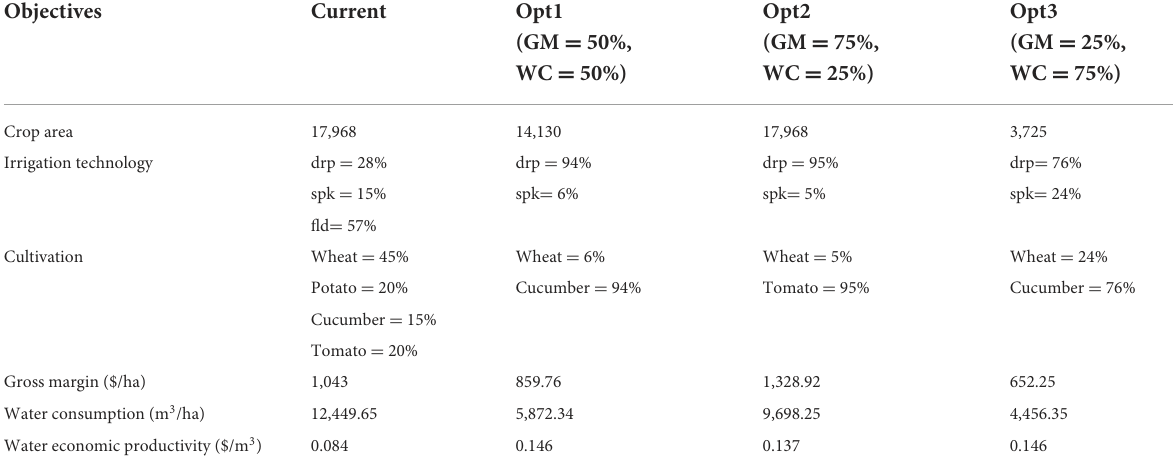
TABLE 1 Results of economic-environmental optimal